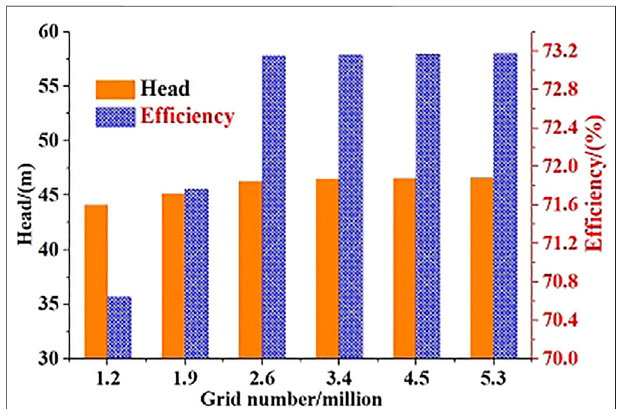
FIGURE 2 | Grid sensitive